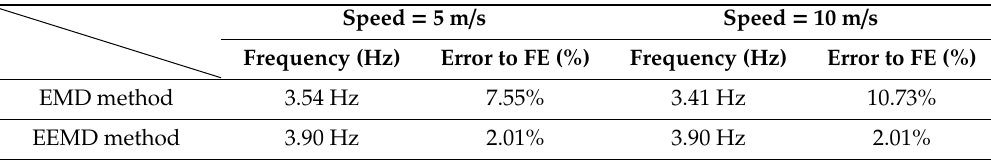
Table 2. Comparison of the frequency estimated by EMD and EEMD for di ff erent vehicle